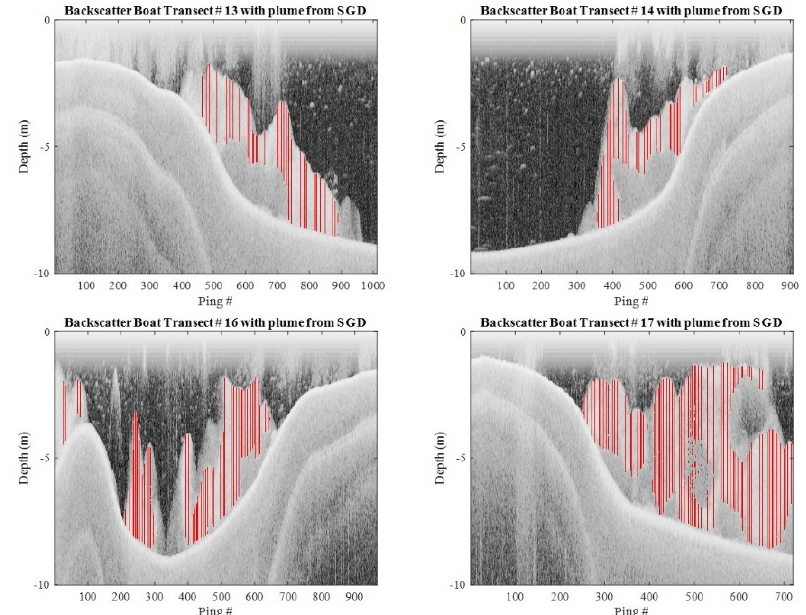
Figure 3. Backscatter from different sonar transects, numbering according to Figure 2c.